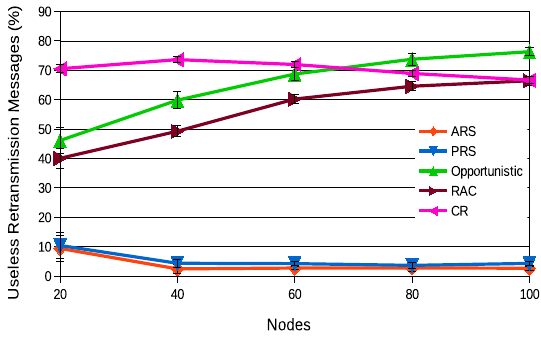
Figure 14. Percentage of useless retransmission messages for a dynamic